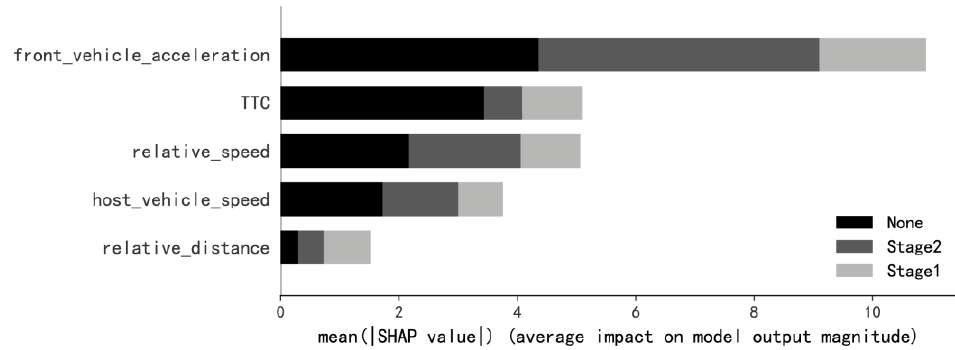
Figure 9. Results of the SHAP summary plot.